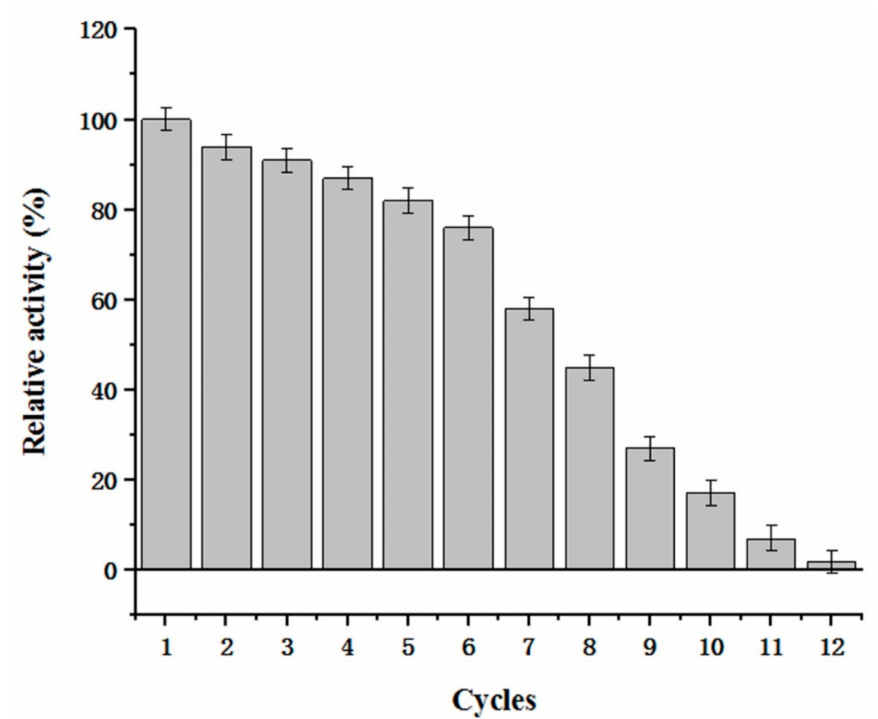
Figure 11. Reusability of displayed CDA. The remaining activity represents the displayed CDA activity after being used for N cycles/unused displayed CDA